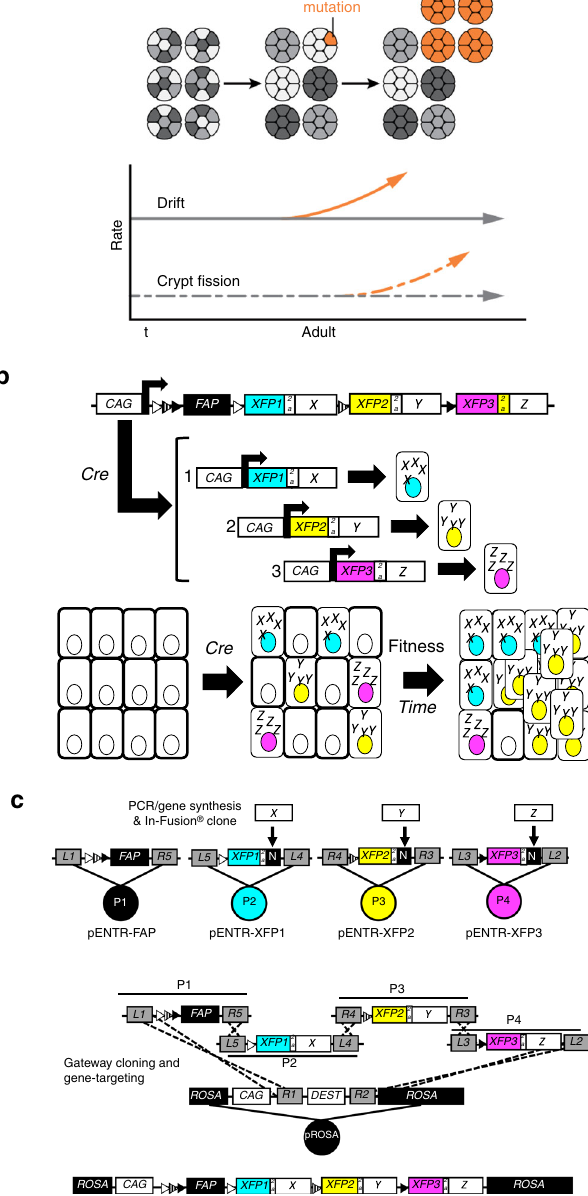
Fig. 1 Engineering cancer rainbow mice. a The current two-step model of intestinal fi eld cancerization. Somatic mutations increase stem cell fi tness and lead to the fi xation of premalignant clones within crypts (orange). Crypt fi ssion results in duplication of premalignant crypts and the lateral propagation of somatic fi elds. b The Crainbow expression vector incorporates 4-tandem cassettes downstream of the ubiquitous chicken- β - actin promoter (CAG). The construct confers ubiquitous expression of a membrane-targeted and chemically inducible near-infrared fl uorogen- activating peptide (FAP-Mars1) as a control. Cell type speci fi c activation of Cre recombinase mediates recombination at one of three positions through inclusion of three pairs of orthogonal lox sites (LoxN: white triangle, Lox2272: hatched triangle, and LoxP: fi lled triangle). Single-copy transgene insertion provides a single outcome per cell and barcoding of each genetic fate by fl uorescent imaging. c Candidate tumor driver genes are synthesized/PCR ampli fi ed and then In-Fusion ® cloned into a bicistronic expression cassette. Multi-site Gateway ™ cloning is used to directionally clone each pENTR plasmid into a Gateway ™ -compatible ROSA-targeting vector in a single step 21